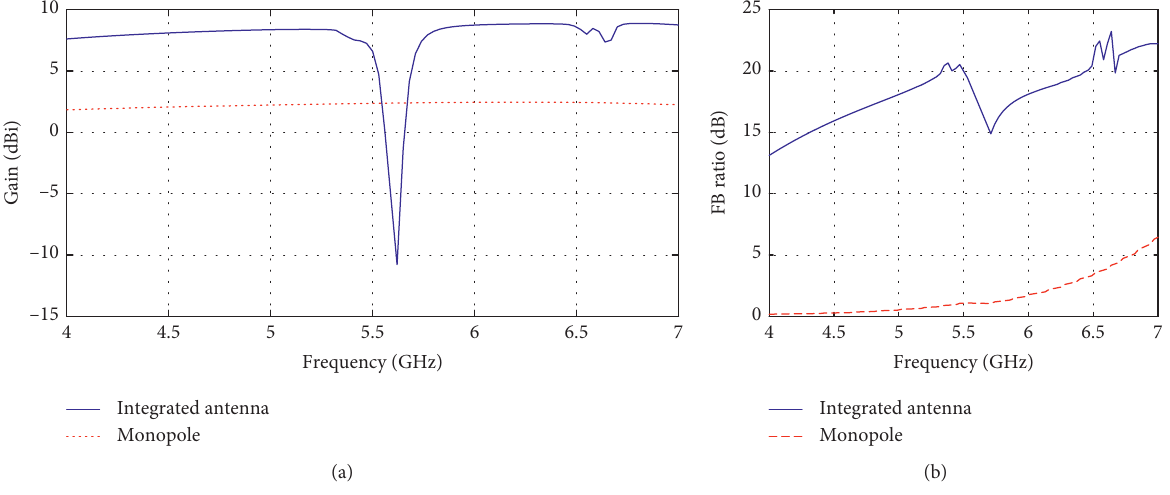
Figure 6: Gain and FB of the monopole and the integrated MSs antenna.